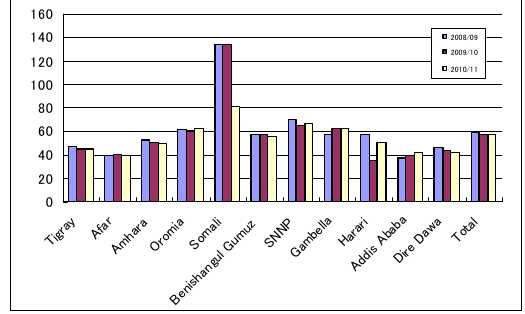
(Source: Education Statistics Annual Abstract of each year) Figure 4-13: Secondary (Grade 9 – 12) Pupil Section Ration by Region (2008/09 -